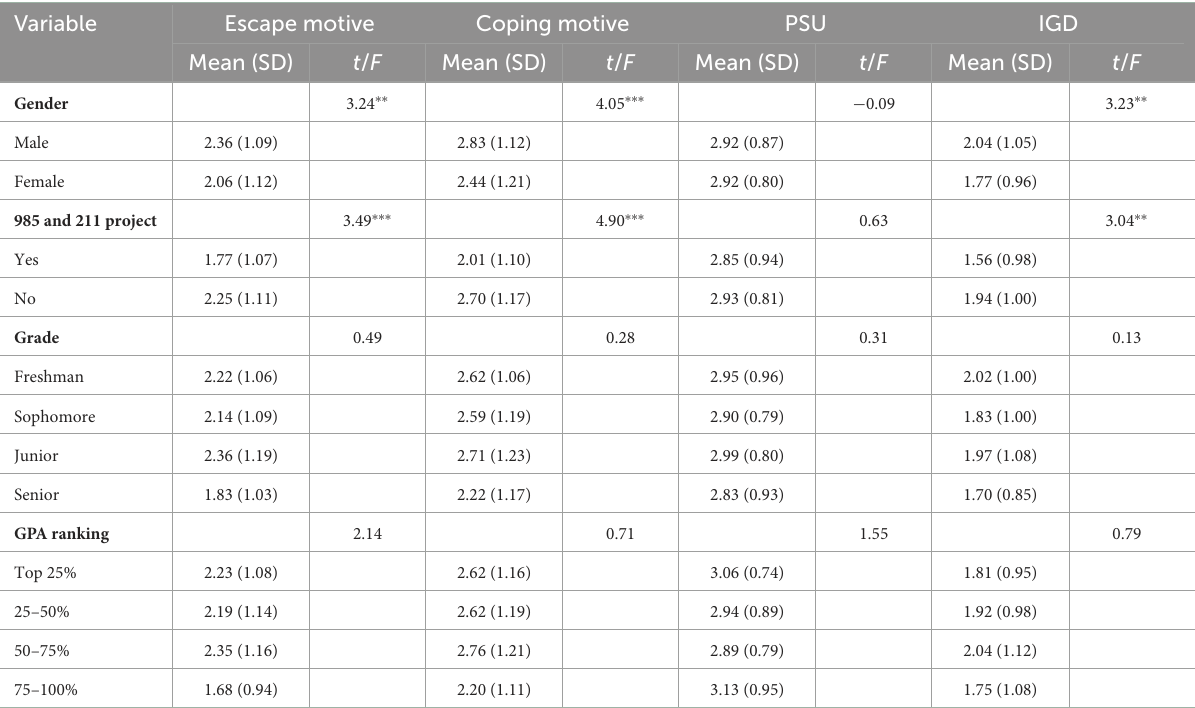
TABLE 2 Descriptive statistics of psychological and behavioral variables analyzed in this study. Variable Escape